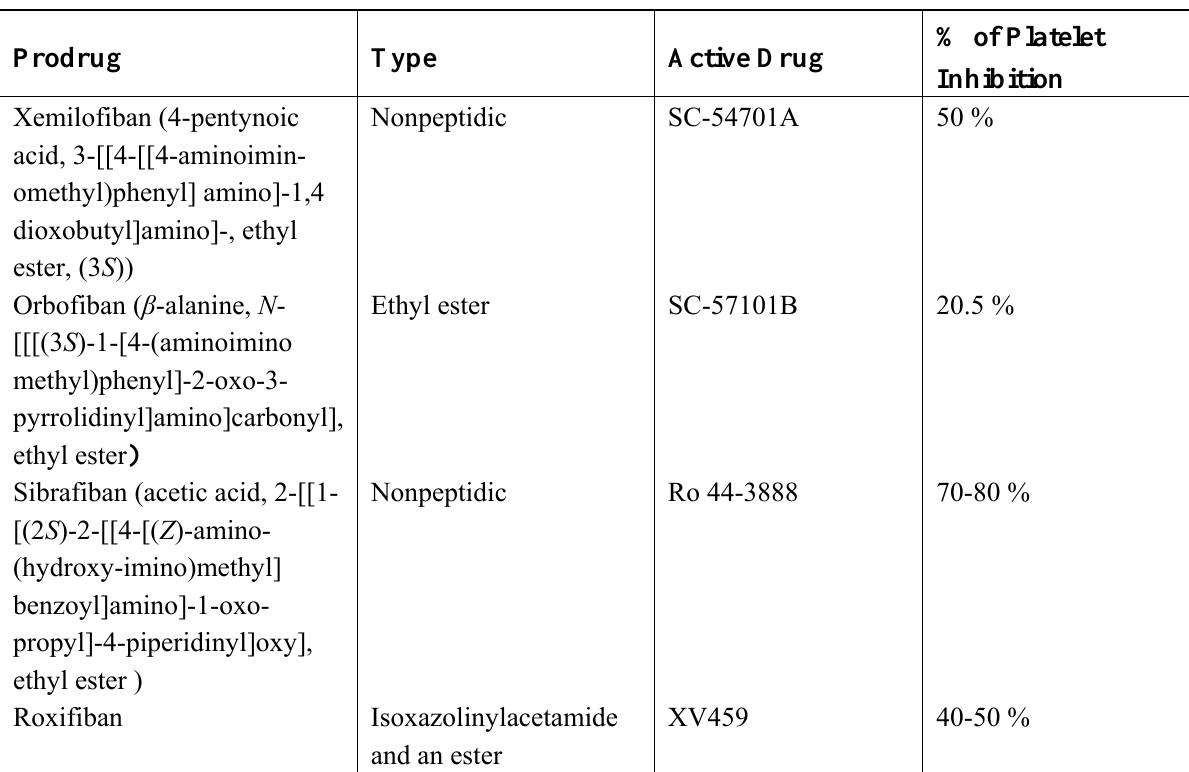
Table 1. A list of prodrugs orally administrated that inhibit platelet